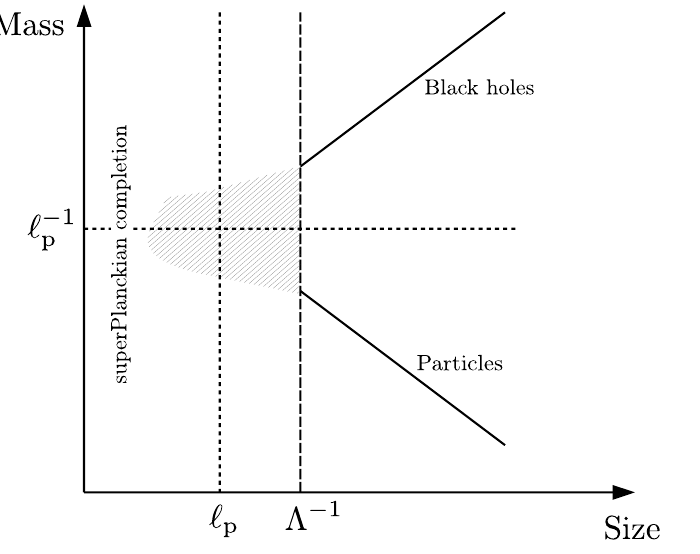
Figure 1 . Sketch of physical states near the Planck scale. The graviton + matter QFT and semiclassical black hole physics both fail at short distance scales below 1 = (cid:3), which is some length p greater than the Planck length ‘ Pl (cid:17) G N . The hatched area within the mass range (cid:24) (cid:3) (cid:0) may contain UV states leaving an imprint in the sub-Planckian e(cid:11)ective QFT, including global symmetry